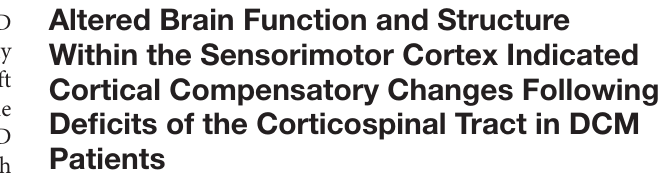
FIGURE 2 | The global functional connectivity density differences between degenerative cervical myelopathy patients and healthy controls. IOC, inferior occipital cortex; CV, cerebellum vermis; SMA, supplementary motor area; Tha, thalamus; SFG, superior frontal gyrus; l, left; r, right. * P < 0.05.